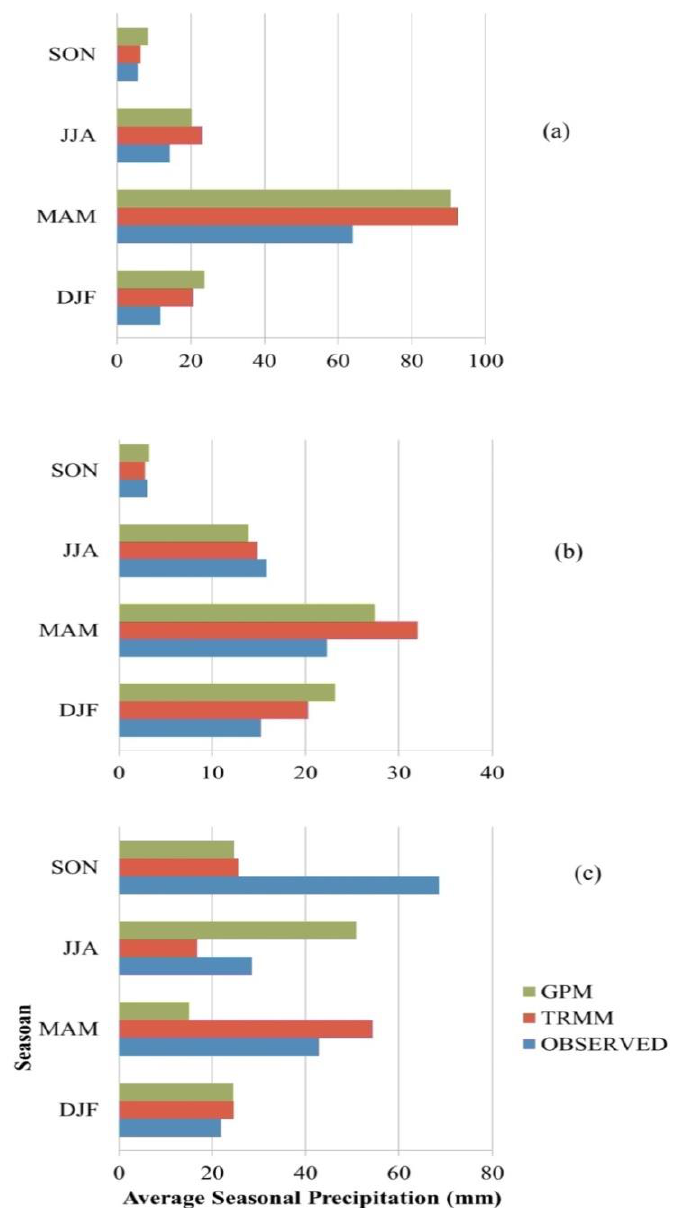
Figure 6. Seasonal averages of precipitation estimates from NCSI (OBSERVED, (blue)), GPM (green), and TRMM (red) for the entire country in ( a ) 2016, ( b ) 2017, and ( c ) 2018. Monthly precipitation data were accumulated into the season time scale as: spring (MAM: March, April, and May), summer (JJA: June, July, and August), and fall (SON, September, October, and